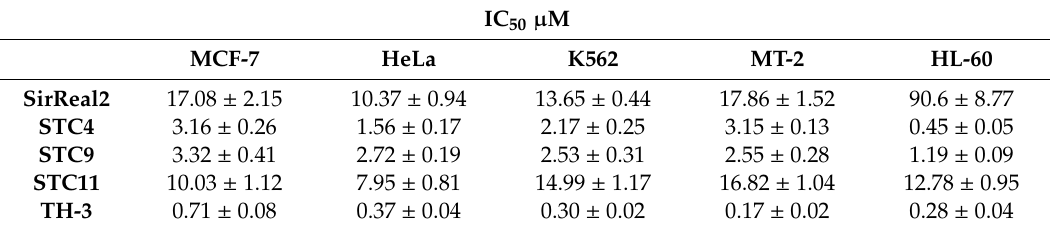
Table 2. IC 50 values of selected compounds against multiple cancer cell